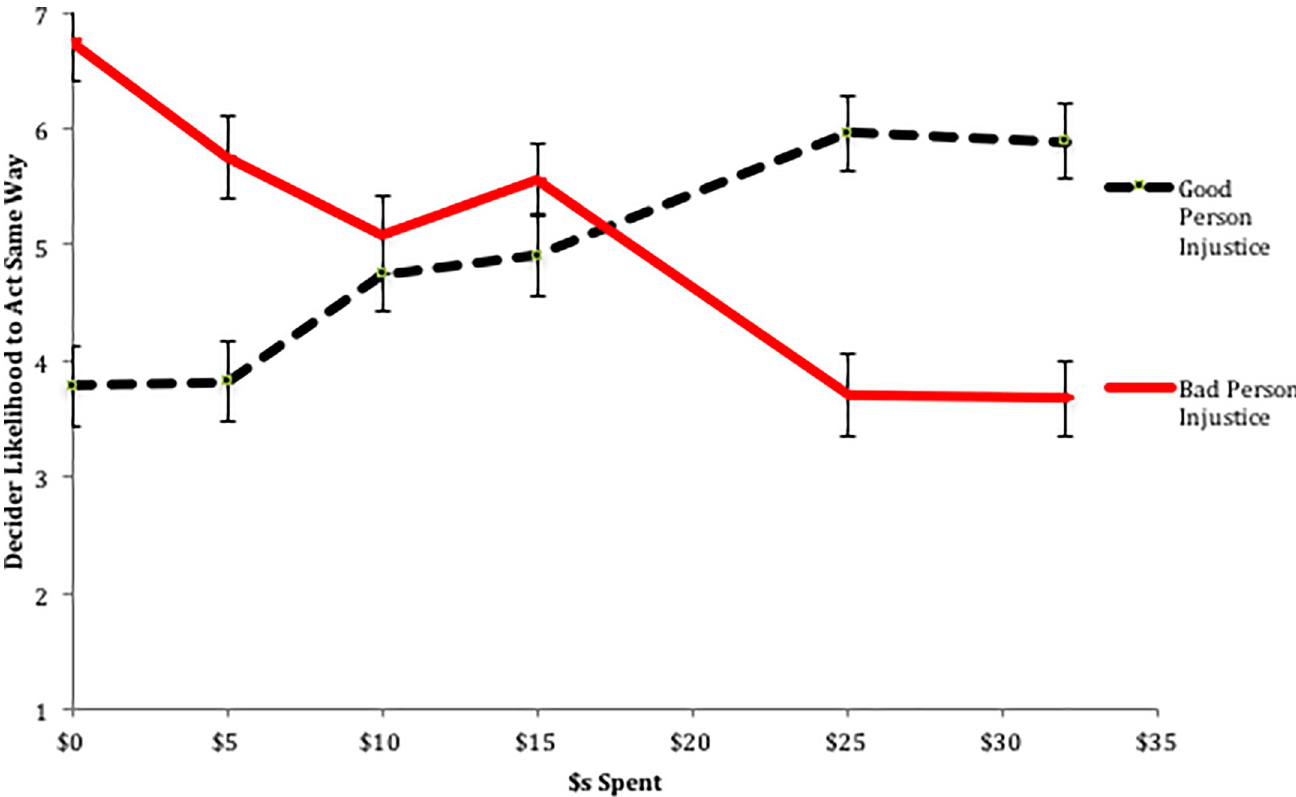
Fig 7. Study 3 Belief about decider’s likelihood to act the same way again. Error bars represent standard errors.